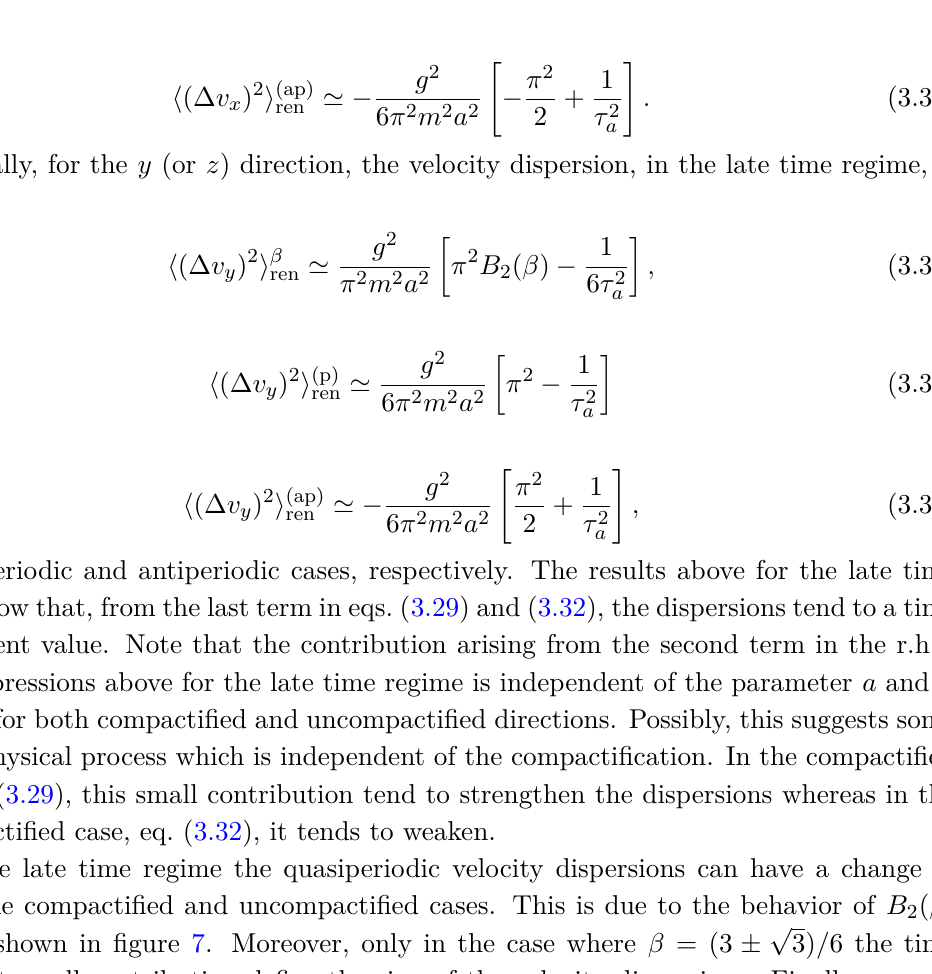
Figure 7 . Bernoulli polinomials B 2 ( β ) , solid line, and B 4 ( β ) , dashed line, as functions of the quasiperiodic parameter β